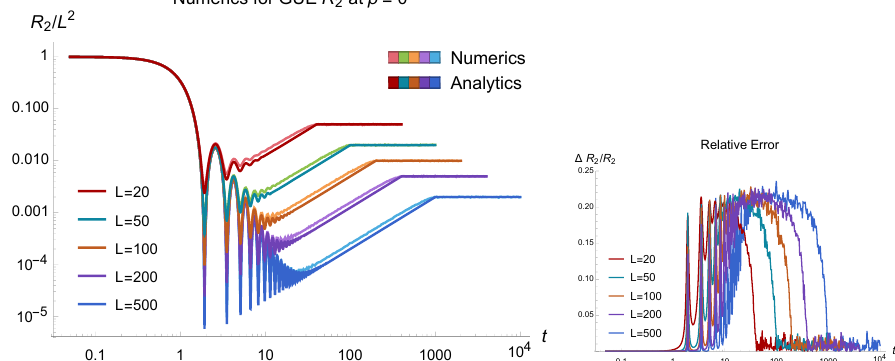
Figure 8 . Numerical checks of the GUE 2-point spectral form factor at in(cid:12)nite temperature for various values of L and normalized by L 2 . The analytic expressions derived in section 2 are in the lighter shades and the numerics for GUE are in darker shades. Numerics were done 10000 samples from the GUE. On the right we plot the relative error between the numerics and analytic predictions. We observe good agreement at early and late times, and see deviations around the ramp.